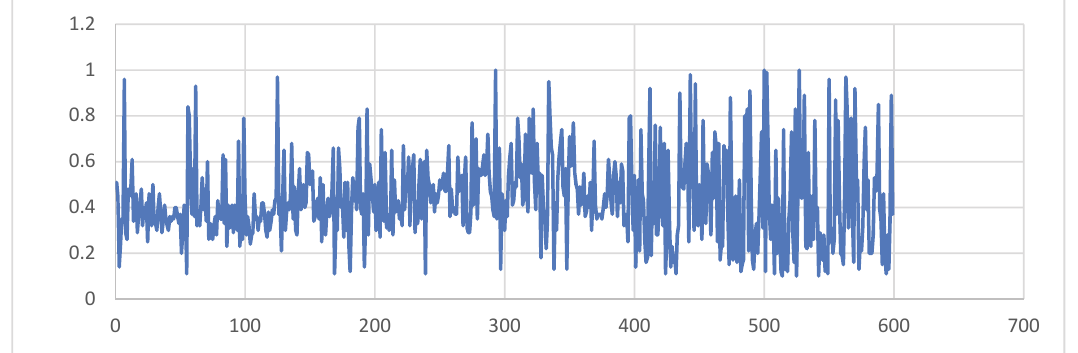
Fig. 4. The results of measuring the relative efficiency of different